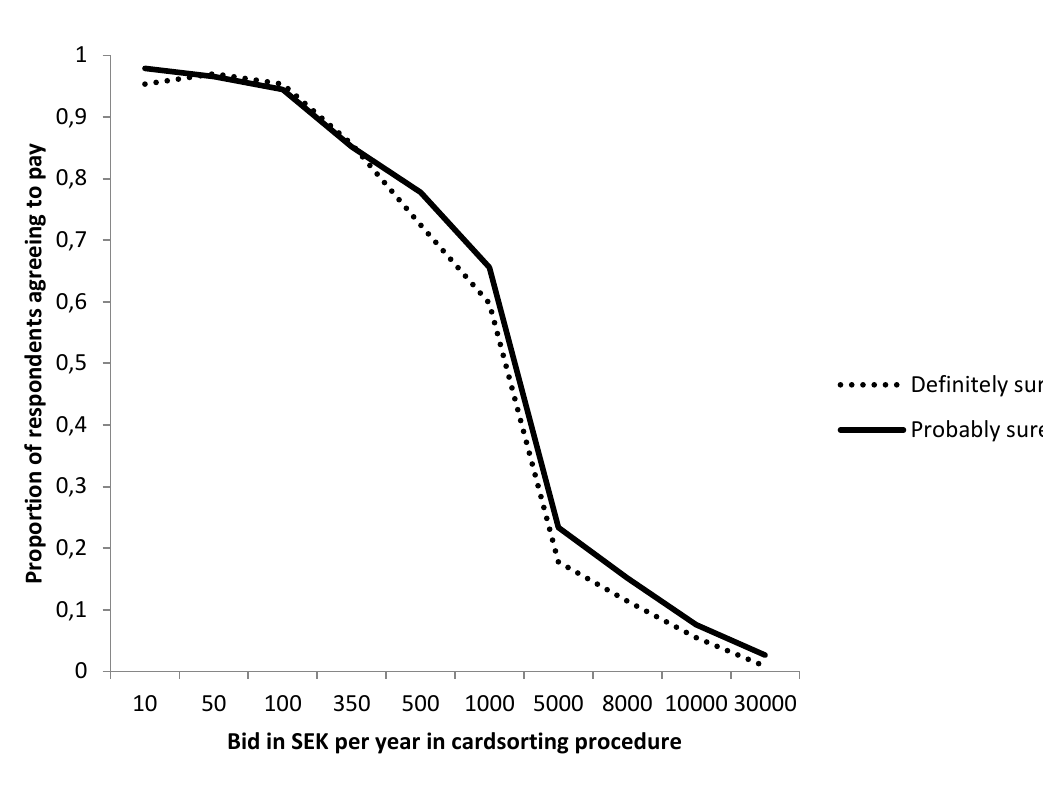
Figure 3: Proportion of respondents agreeing to pay for the insurance at different bids in the card-sorting